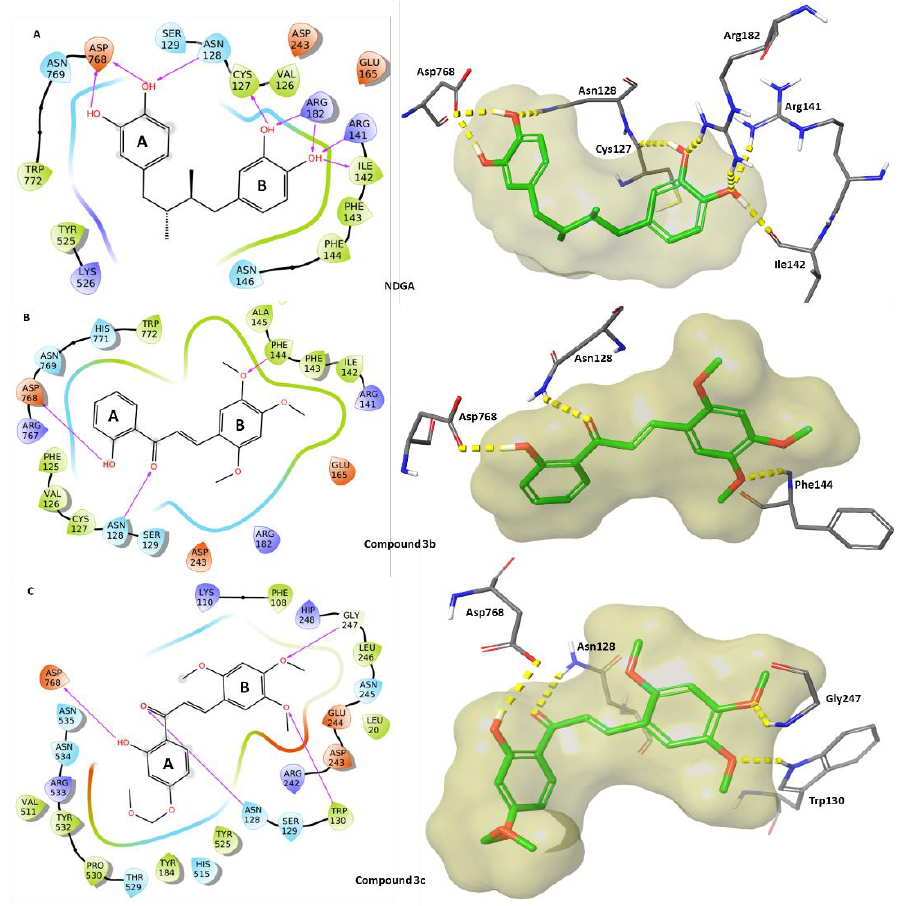
Figure 2. 2D and 3D representative binding poses of ( A ) nordihydroguaiaretic acid ( NDGA ), ( B ) Compound 3b , and ( C ) Compound 3c are depicted. Hydrogen bonds are illustrated with pink (2D) and yellow (3D) color lines. Figure made with MAESTRO (Schrödinger Release 2020-4: Maestro, Schrödinger, LLC, New York, NY, USA, 2020).